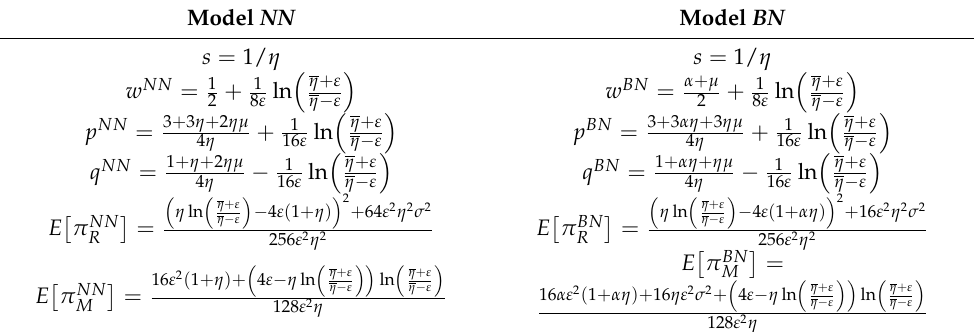
Table 4. Outcomes in Model